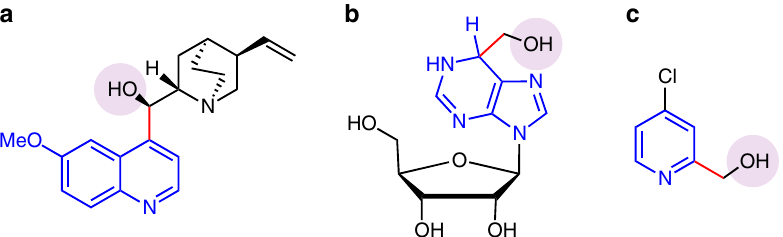
Fig. 1 Important molecules containing alcoholic hydroxyl groups. a Anti-malarial natural product quinine. b Inhibitor of adenosine deaminase. c Inhibitor of gastric acid secretion